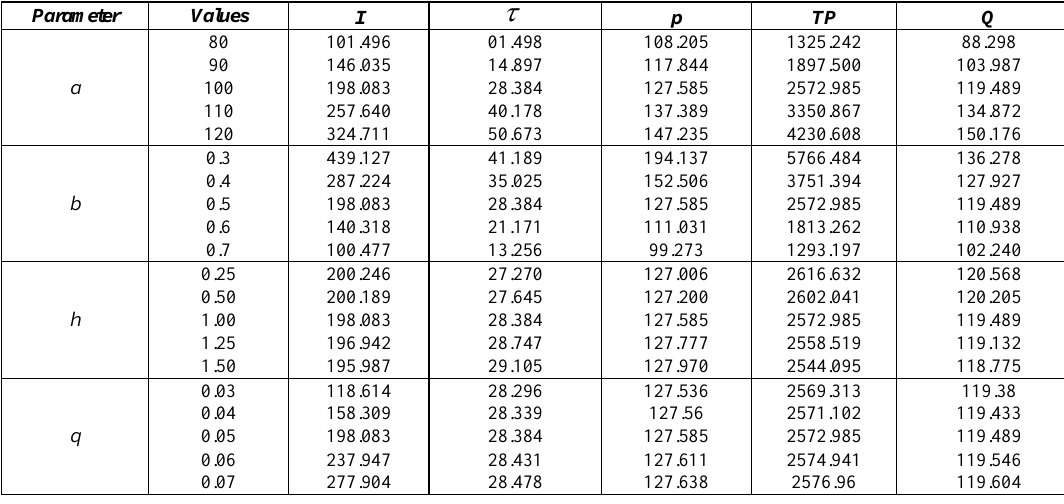
Table 2. Impact of various parameters on the optimal